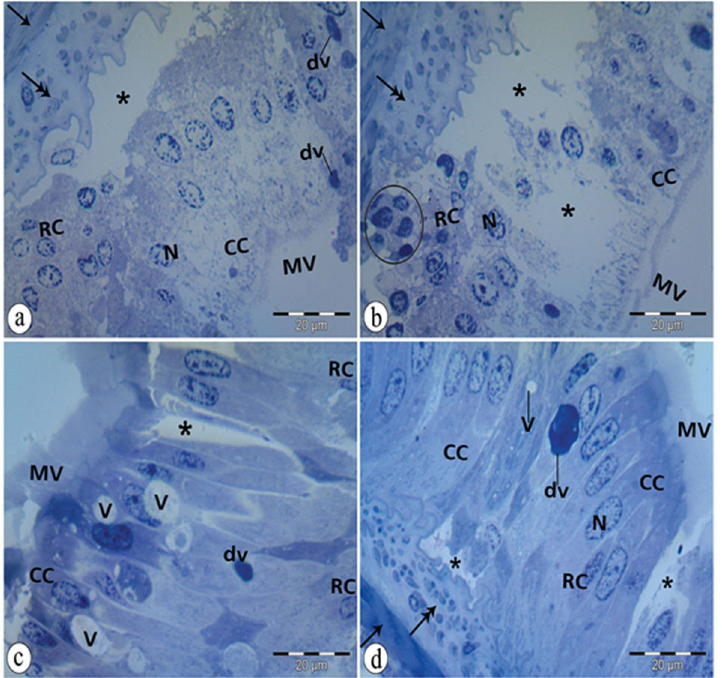
Fig 6. A semithin section of abnormal midgut epithelium. a: lytic cytoplasm ( � ), regenerative cell (RC) with pale nucleus (N), distorted columnar cell (CC), ruptured microvilli (MV), circular muscle (arrow), longitudinal muscle (double head arrow), dense vesicle (dv). b: massive disruption of the midgut epithelium with lytic cytoplasm ( � ), distorted microvilli (MV), necrotic regenerative cells (RC) with pyknotic nuclei (circle), columnar cell (CC) with pyknotic nuclei. N: nucleus, double head arrow: longitudinal muscle. c: lytic cytoplasm ( � ), distortion of microvilli (MV), columnar cell (CC) with a heterochromatic nucleus, regenerative cell (RC), vacuoles (V), dense vesicle (dv). d: lytic cytoplasm ( � ), microvilli (MV), regenerative cell (RC), columnar cell (CC), nucleus (N), vacuole (V), dense vesicle (dv), circular muscle (arrow), longitudinal muscle (double head arrow).